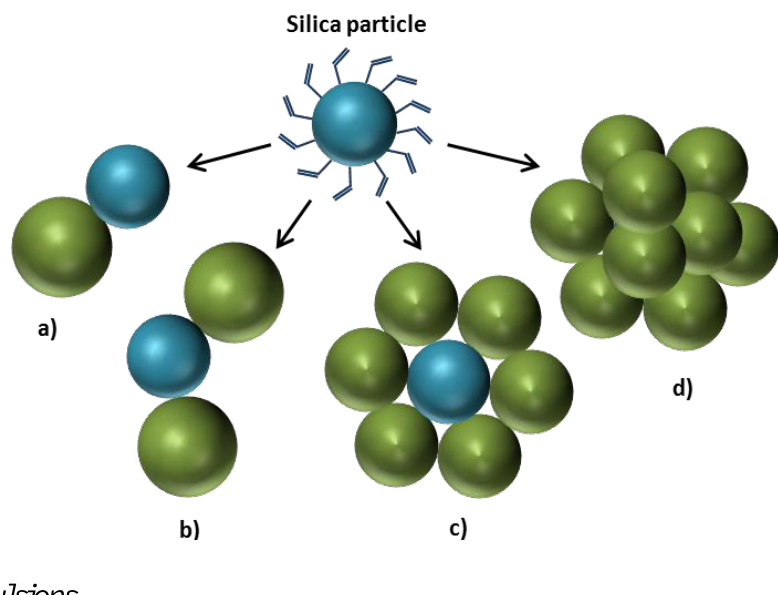
Figure 8. Morphology control over polystyrene growth on silica nanoparticles: ( a ) polystyrene/silica ratio equal to 1; ( b ) polystyrene/silica ratio equal to 2; ( c ) polystyrene/silica ratio equal to 6; ( d ) polystyrene in excess respect to silica. (Self-drawn scheme based on the strategy reported in